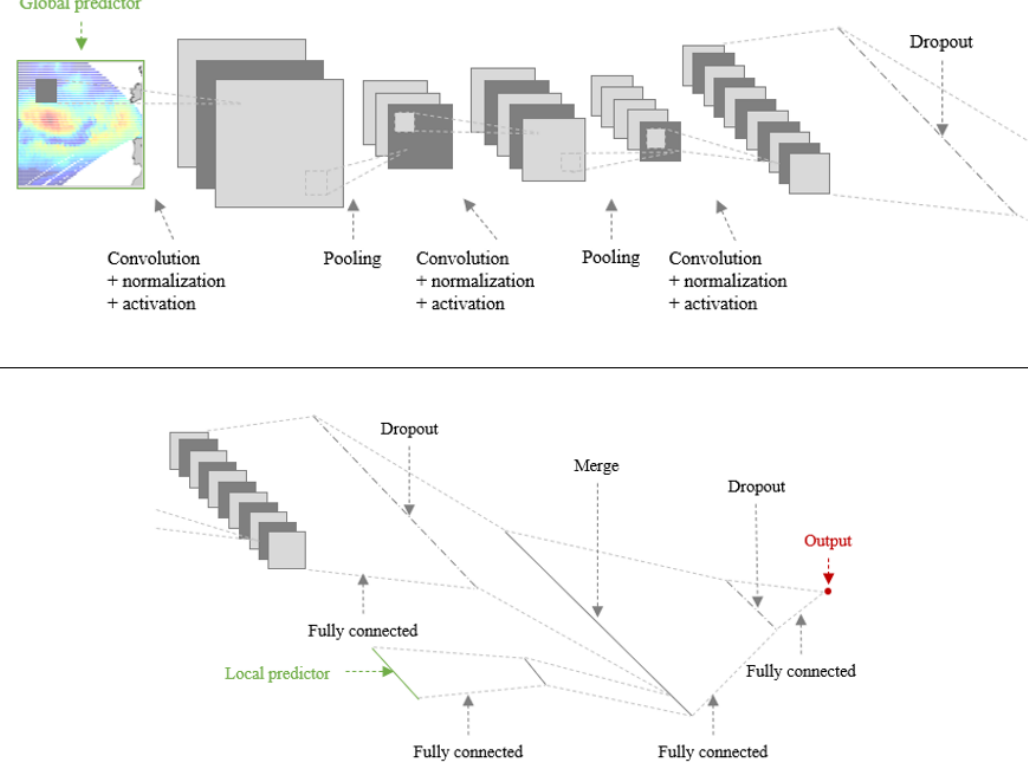
Figure 3. Architecture of the hybrid neural network.